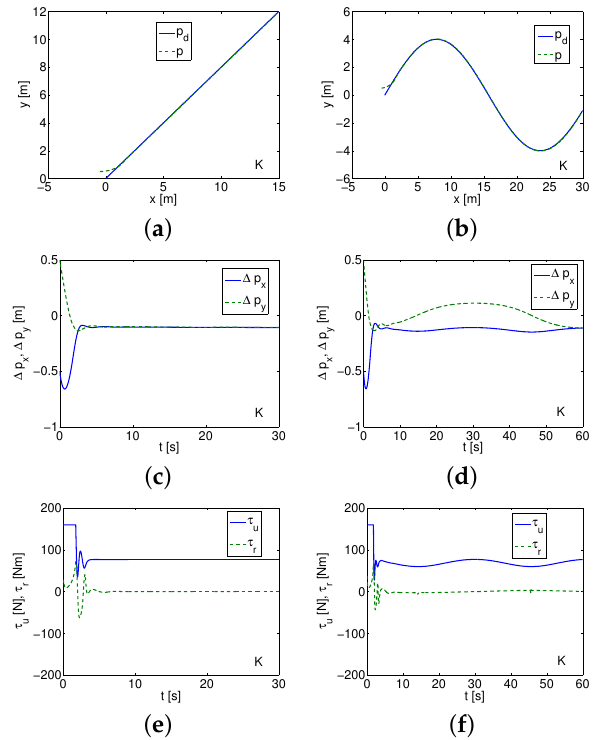
Figure 8. Simulation results for Kambara (terminal sliding mode control (TSMC))—linear and sine trajectory. ( a , b ) Desired and realized trajectory; ( c , d ) position errors; ( e , f ) applied forces/torques.